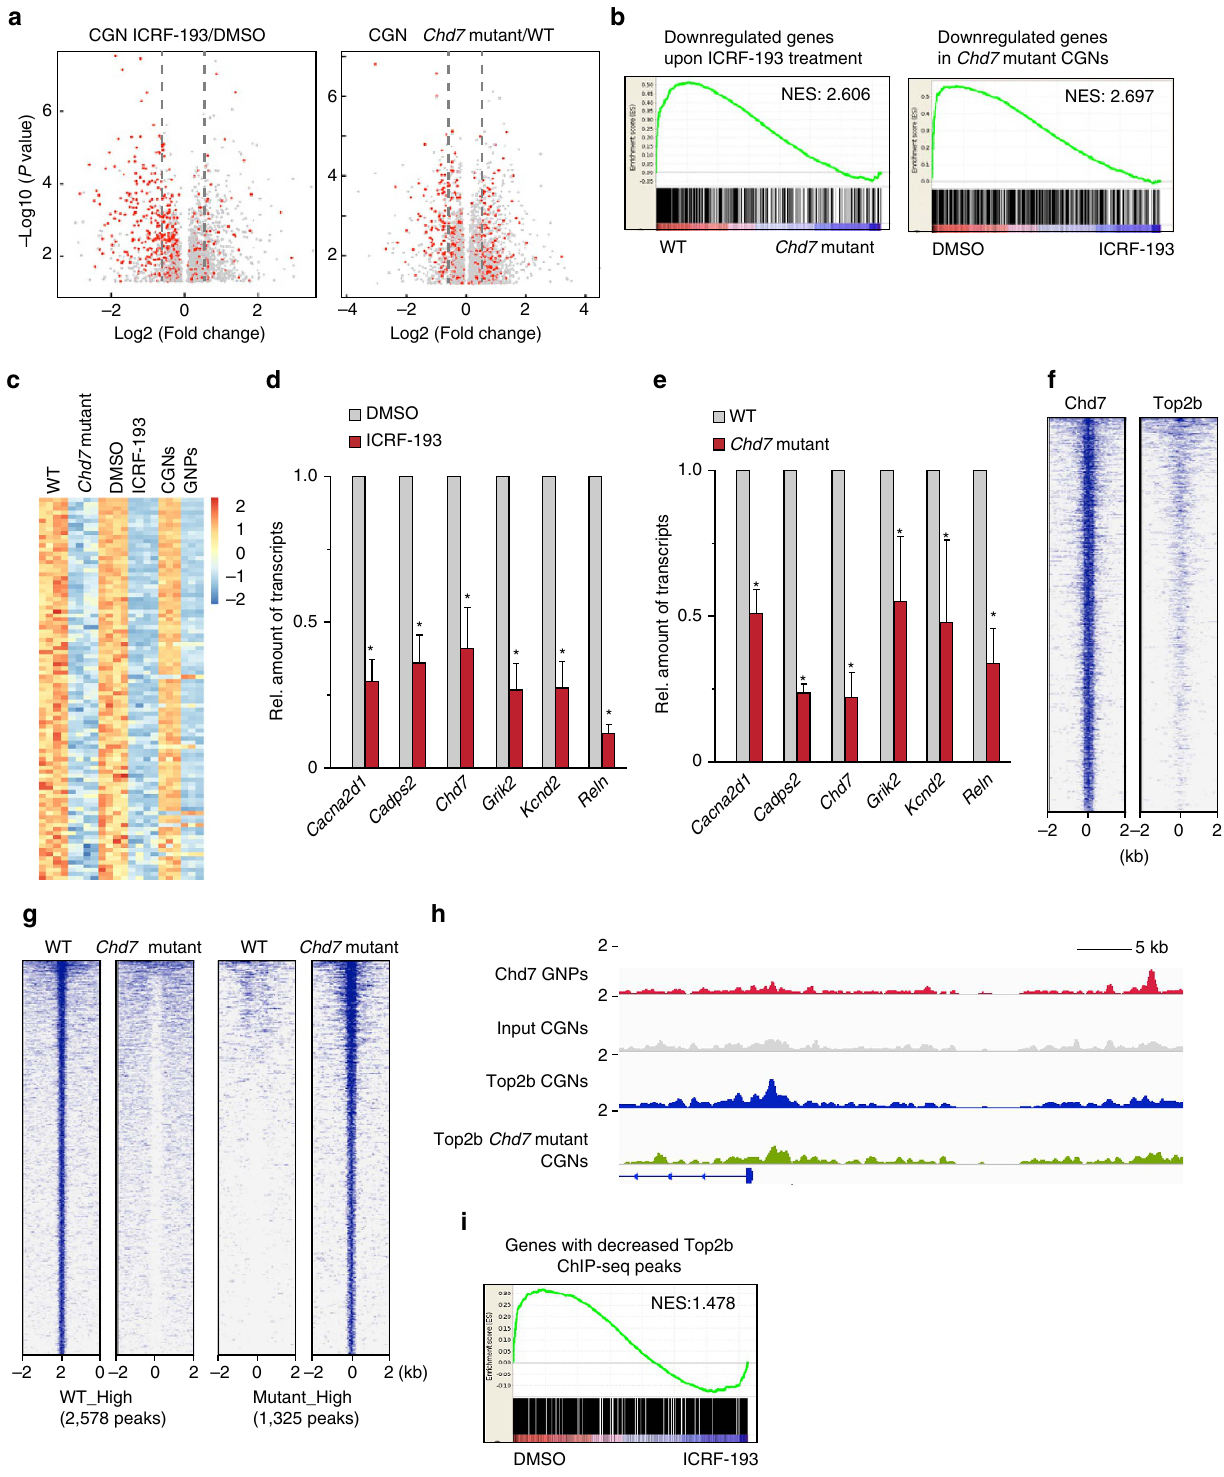
(Fig. 7c), as observed in Chd7 -deficient [ Atoh1-Cre::Chd7 f/f ] mice. On the other hand, the percentage of proliferating (Ki67 þ ) and differentiating (p27 þ ) cells among GFP þ cells in EGL were not altered upon mutation of Top2b (Fig. 7d), similar to our previous finding that Chd7 loss does not affect cell proliferation of GNPs. Thus, the cerebella bearing Chd7 - or Top2b -deficient granule cells partly share similar phenotype, which supports our conclusion